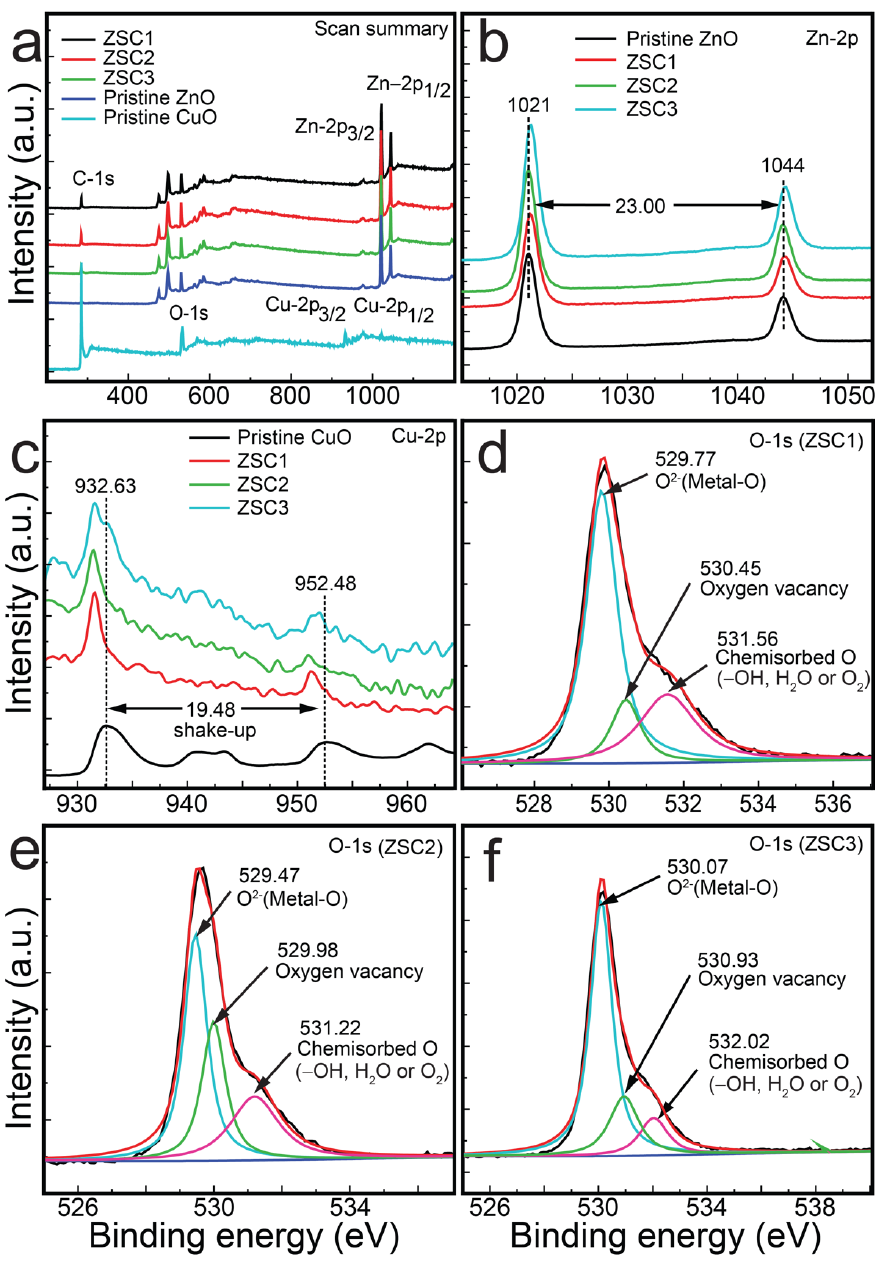
Figure 4. XPS spectra of ZSC nanocomposites and pristine samples: ( a ) survey spectra, ( b ) Zn-2p 3/2 and Zn-2p 1/2 spectra of ZSC nanocomposites and pristine ZnO, ( c ) Cu-2p 3/2 and Cu-2p 1/2 spectra of ZSC nanocomposites and pristine CuO, ( d ) O-1s spectrum of ZSC1, and ( e ) O-1s spectrum of ZSC2, ( f ) O-1s spectrum of ZSC3.